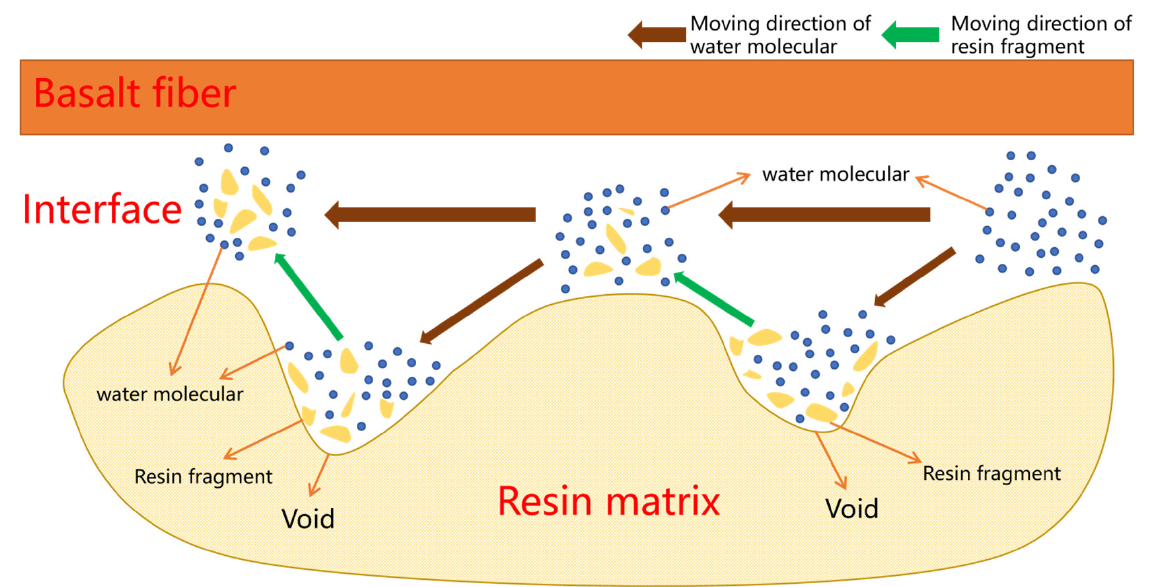
Figure 20. Interface situation of BFRPs.